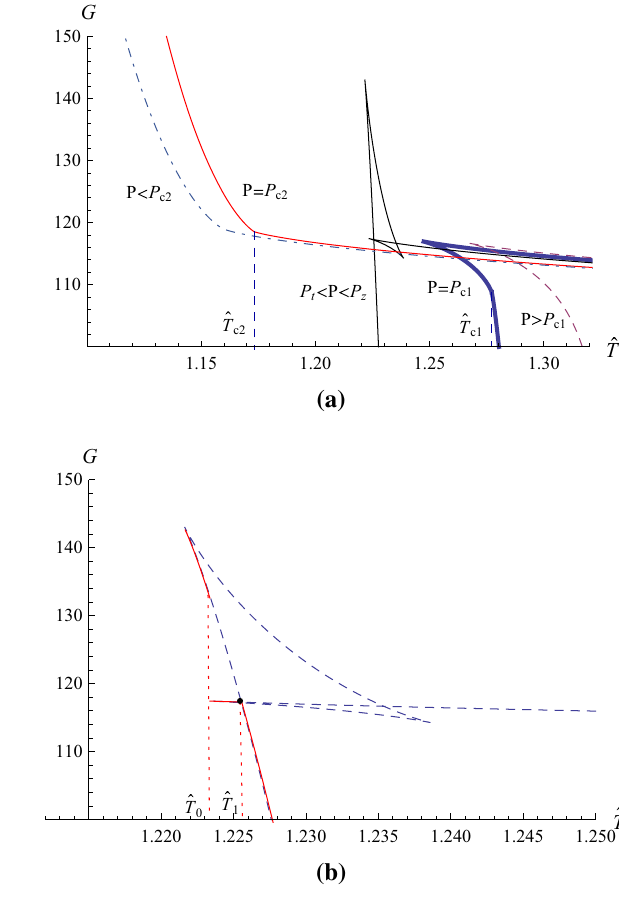
Fig. 3 The G − ˆ T diagrams of six-dimensional AdS black holes for w = − 1, w = 1 and w = − 0 . 7. For P ∈ ( P , P ) , we observe a t z 2 3 4 “zeroth-order phase transition” signifying the onset of an RPT in a . In b with P = 0 . 0869 ∈ ( P t , P z ) ,aclose-upof a illustratesthediscontinuity in the global minimum of G at ˆ T = ˆ T 0 ≈ 1 . 223398 ∈ ( ˆ T t , ˆ T z ) and the so-called Van der Waals-like phase transition at ˆ T = ˆ T 1 ≈ 1 .